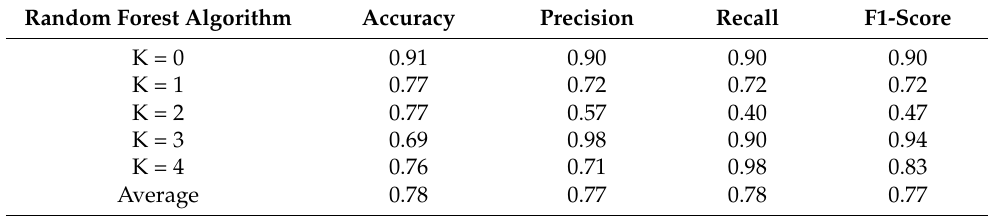
Table 5. Fold-wise evaluation metrics of Random Forest